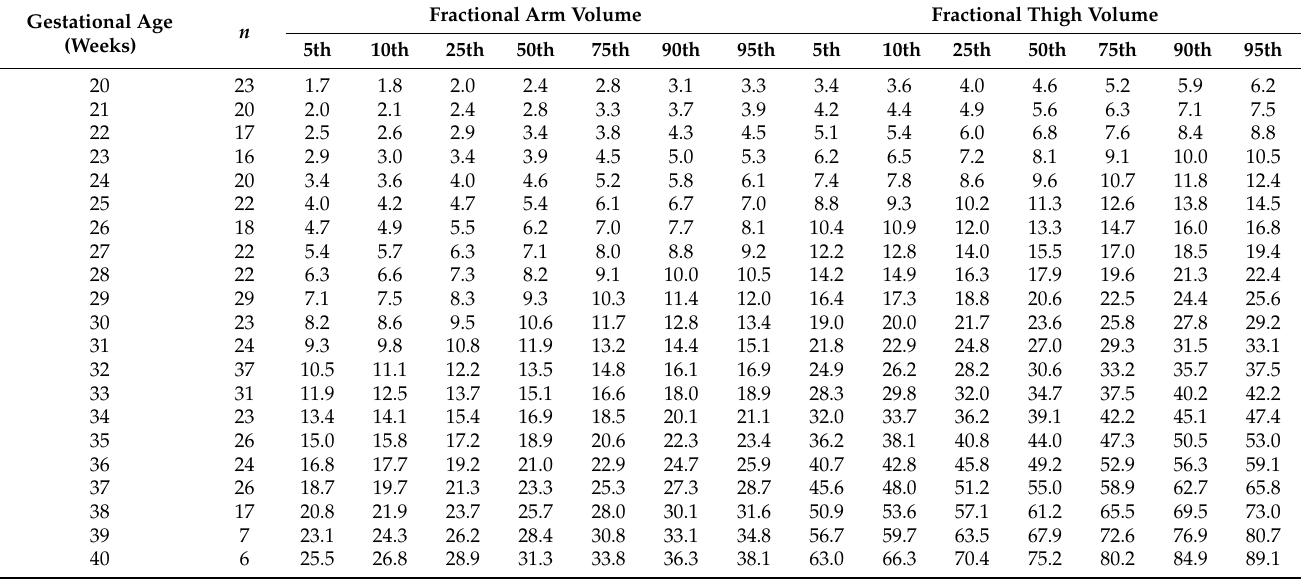
Table 2. Fitted percentiles of fractional limb volume.